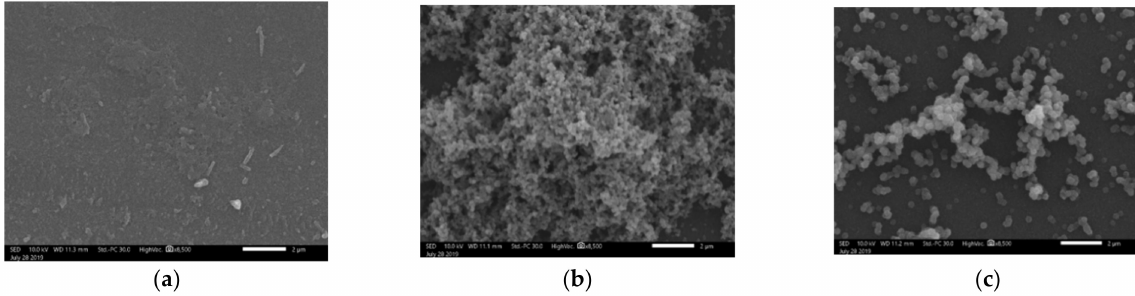
Figure 6. SEM images of coatings composed of: ( a ) TEOS:PrTMS, ( b ) TEOS:DTMS, and ( c ) TEOS:ODTMS at a molar ratio of 5:5. Bar size—2 µ m